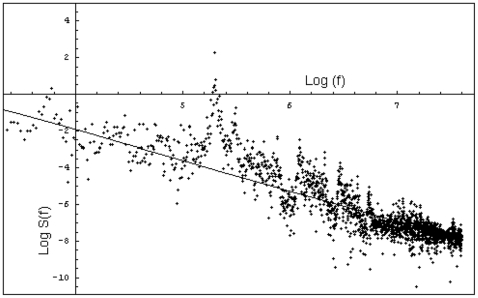
Spectral density plot of a representative series of the dissipative metabolic network.S(f) is the absolute value of the Fourier transform and f the frequency. The opposite of the slope has a value of 1.663; this means that the process is a fractional Brownian motion (fBm).